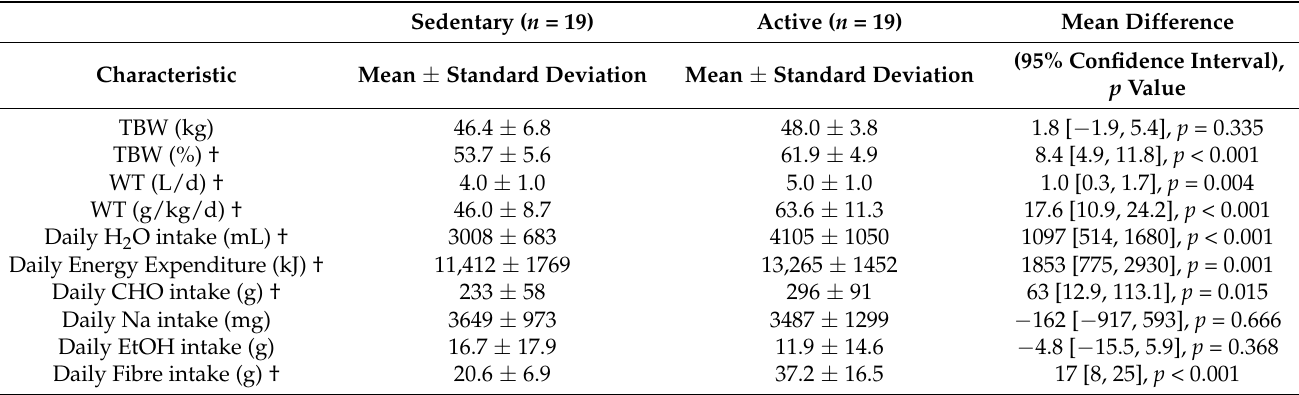
Table 2. Mean ± standard deviation participant body water turnover, body composition, and dietary influencing factors of water turnover rates. Sedentary ( n = 19) Active ( n = 19) Mean Difference (95% Confidence Characteristic Mean ± Standard Deviation Mean ± Standard Deviation